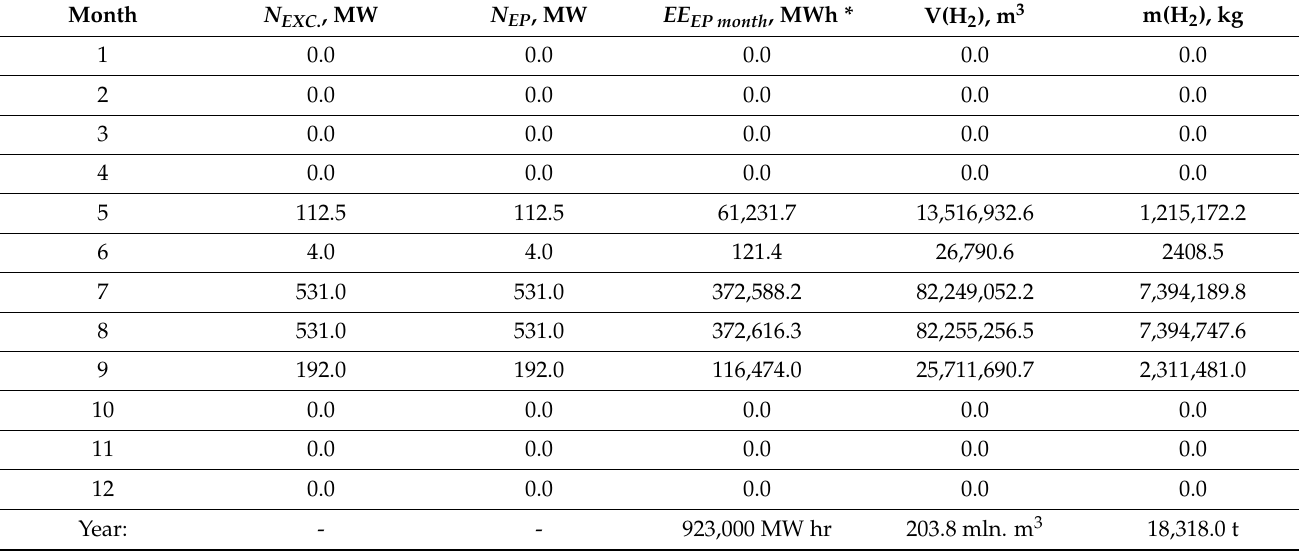
Figure 8. Capital cost of electrolysis depending on capacity of electrolytic unit and technology used.